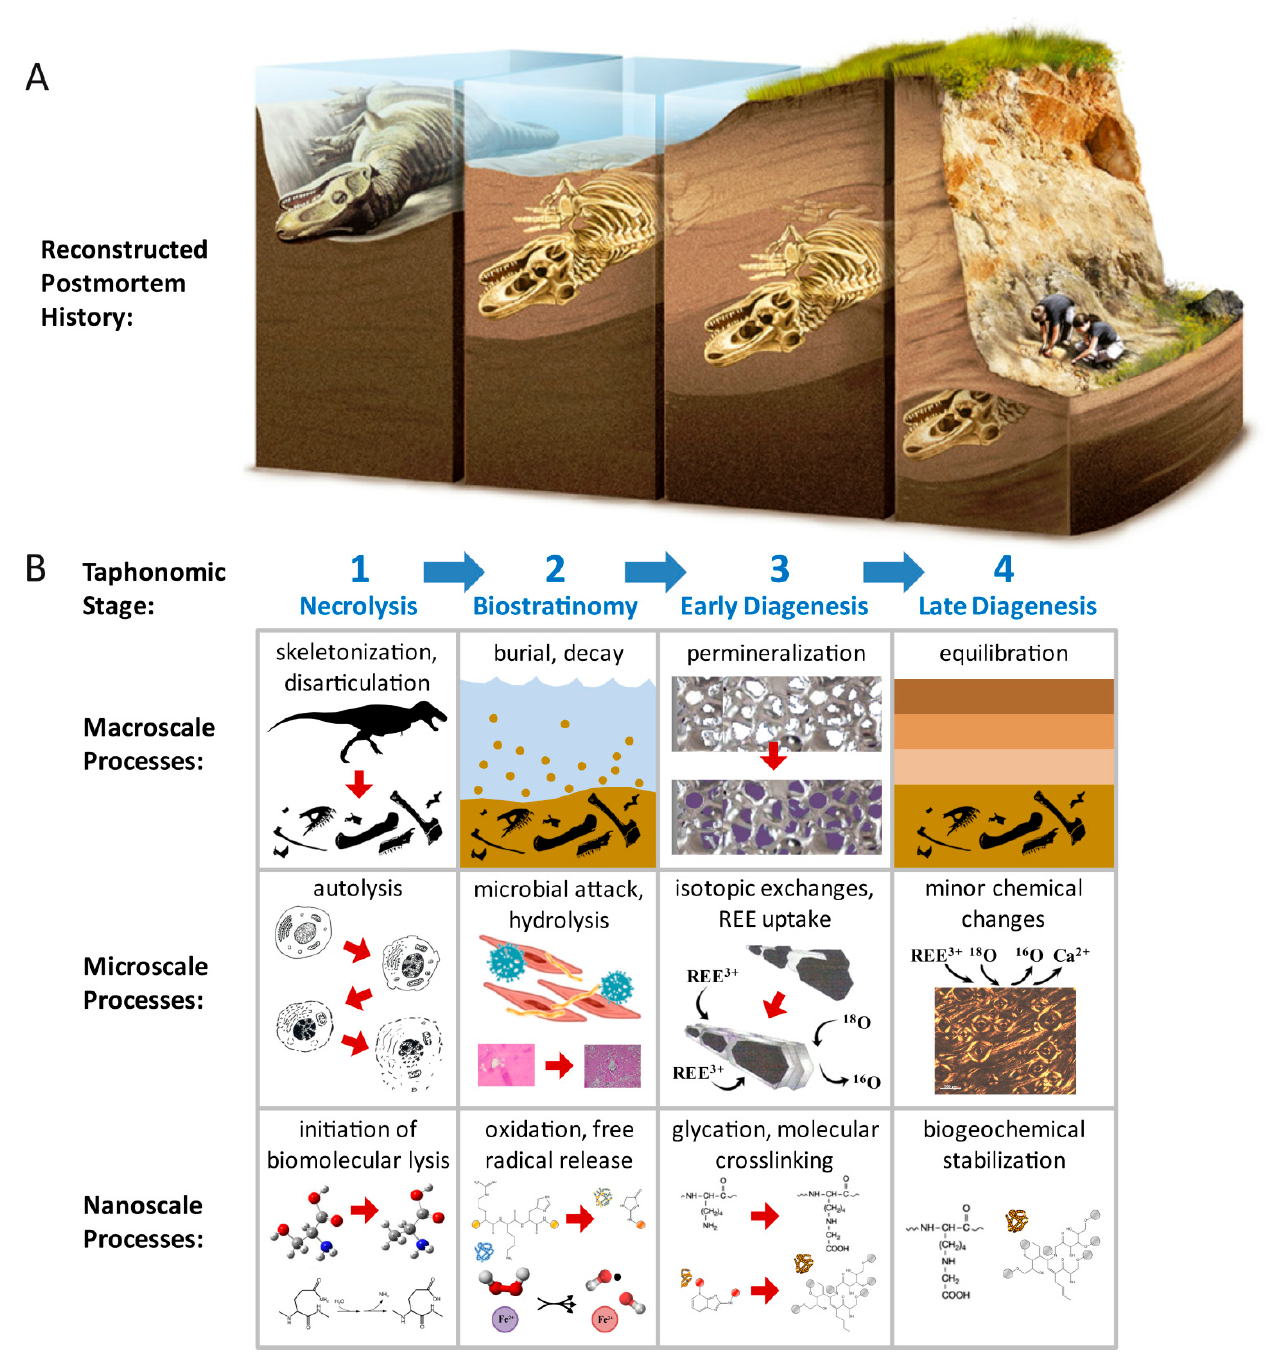
Figure 9. Reconstruction of the taphonomic and diagenetic history of Tyrannosaurus rex MOR 1125. ( A )